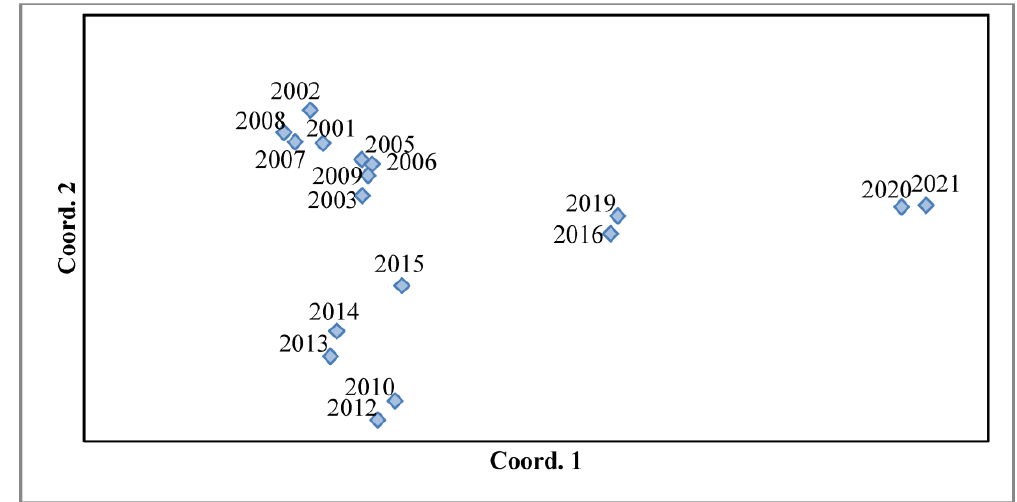
Figure 3. Principal component analysis of relationships among northwestern accessions of Puccinia triticina on common wheat in 2001 – 2021 based on the Roger’s distance.